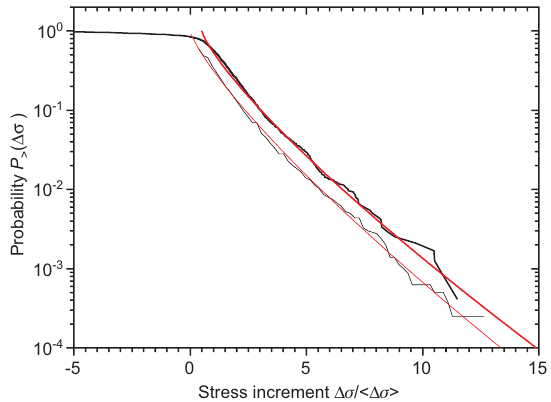
Figure 12 Distribution of stress increments between strain bursts in discrete dislocation simulations of microbending (upper curve) and compression (lower curve; the red lines correspond to Weibull distributions) (modulus β = 0.8).